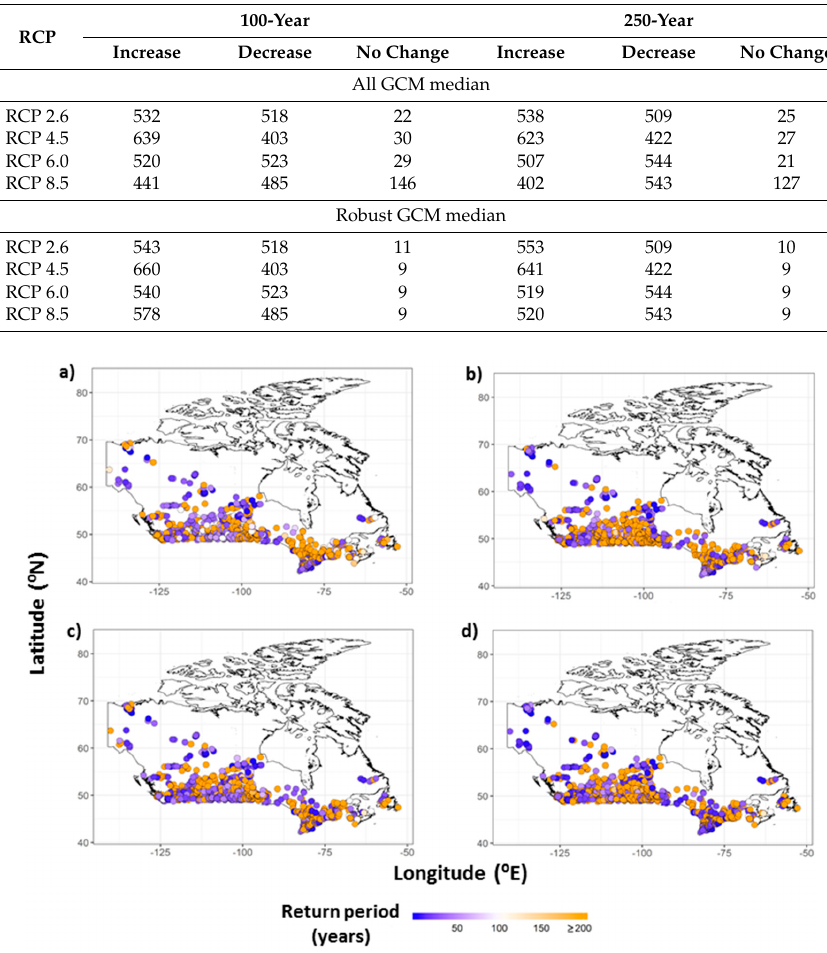
Figure 4. Updated flood frequency of historical 100-year flood magnitudes at FRIs in Canada for ( a ) RCP 2.6, ( b ) RCP 4.5, ( c ) RCP 6.0, and ( d ) RCP 8.5 obtained from robust GCM median approach.